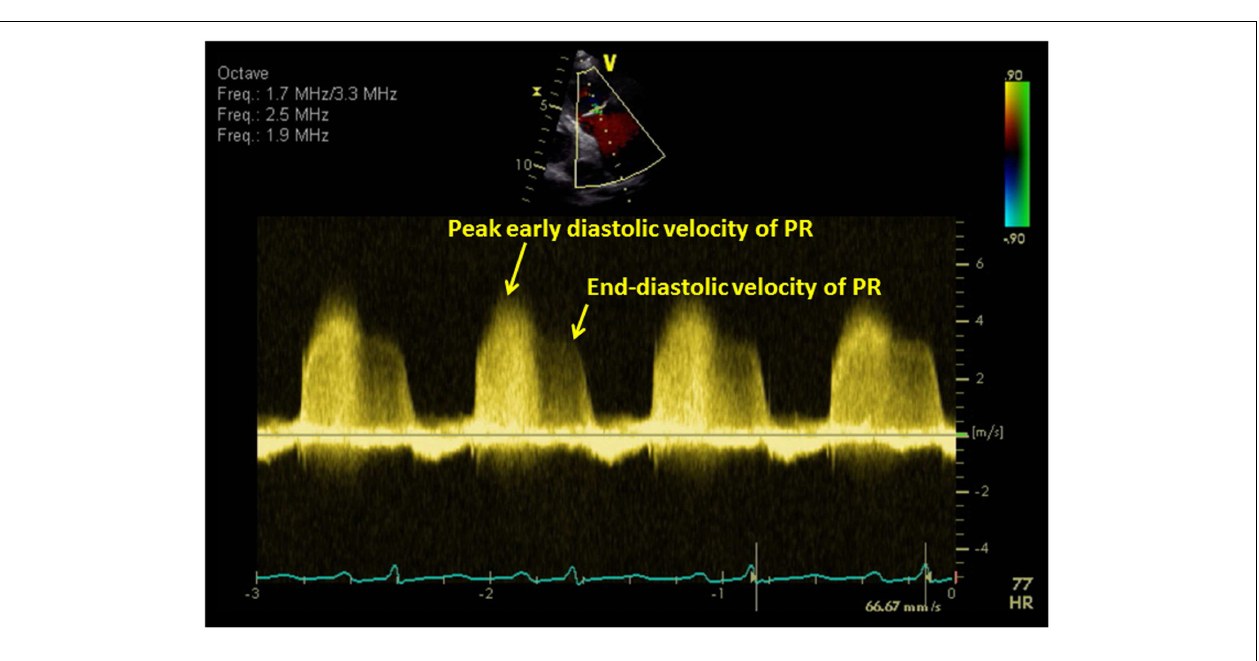
pulmonary artery pressure (mPAP) can be estimated from the following equation: mPAP = 4 V (early peak pulmonary regurgitation velocity) 2 +RA